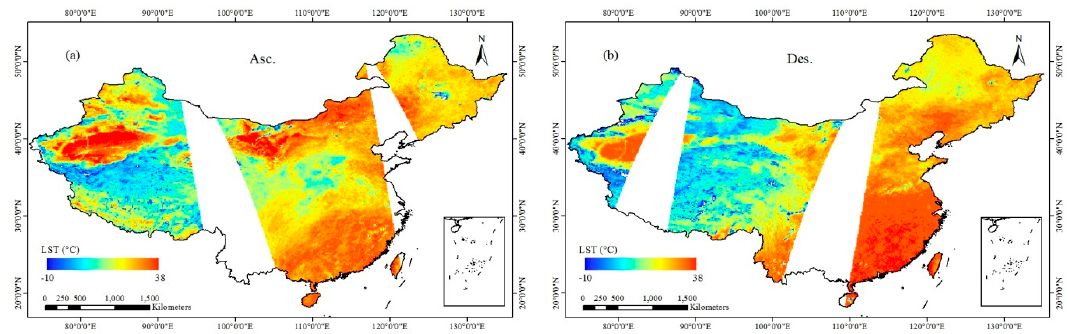
Figure 8. LST distribution of CNN retrieval results in China on August 13, 2016 ( a ) Asc.; ( b ) Des.